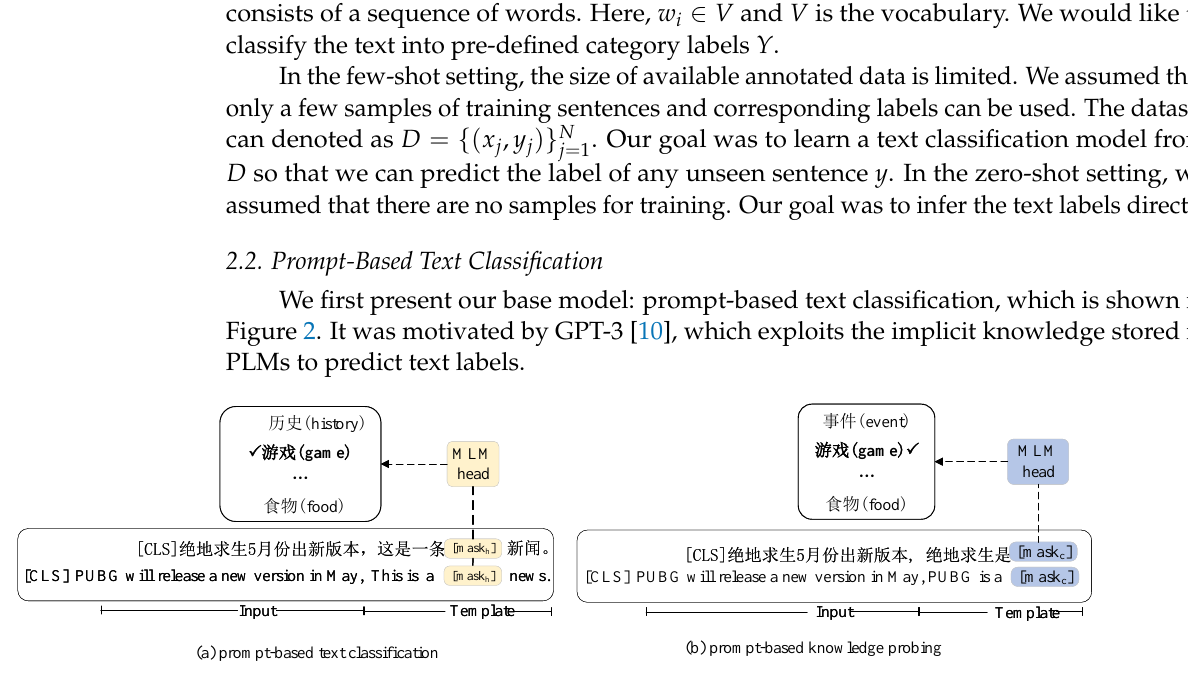
Figure 2. The prompt-based text classification and prompt-based knowledge-probing